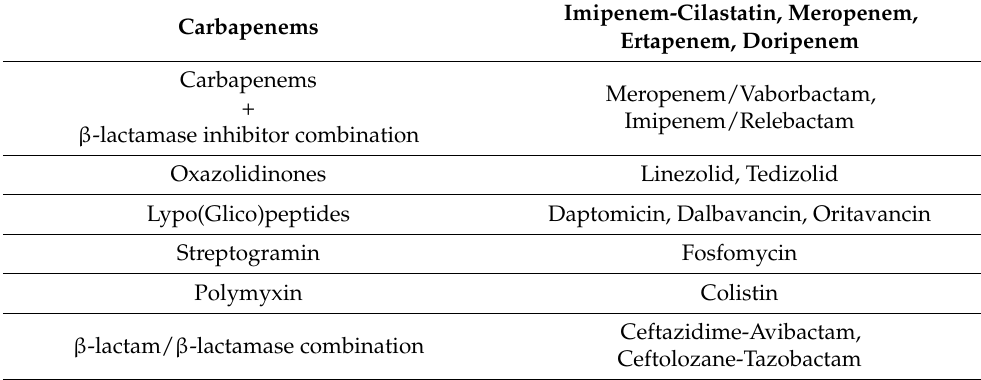
Table 2. Antibiotics used with Antimicrobial Stewardship